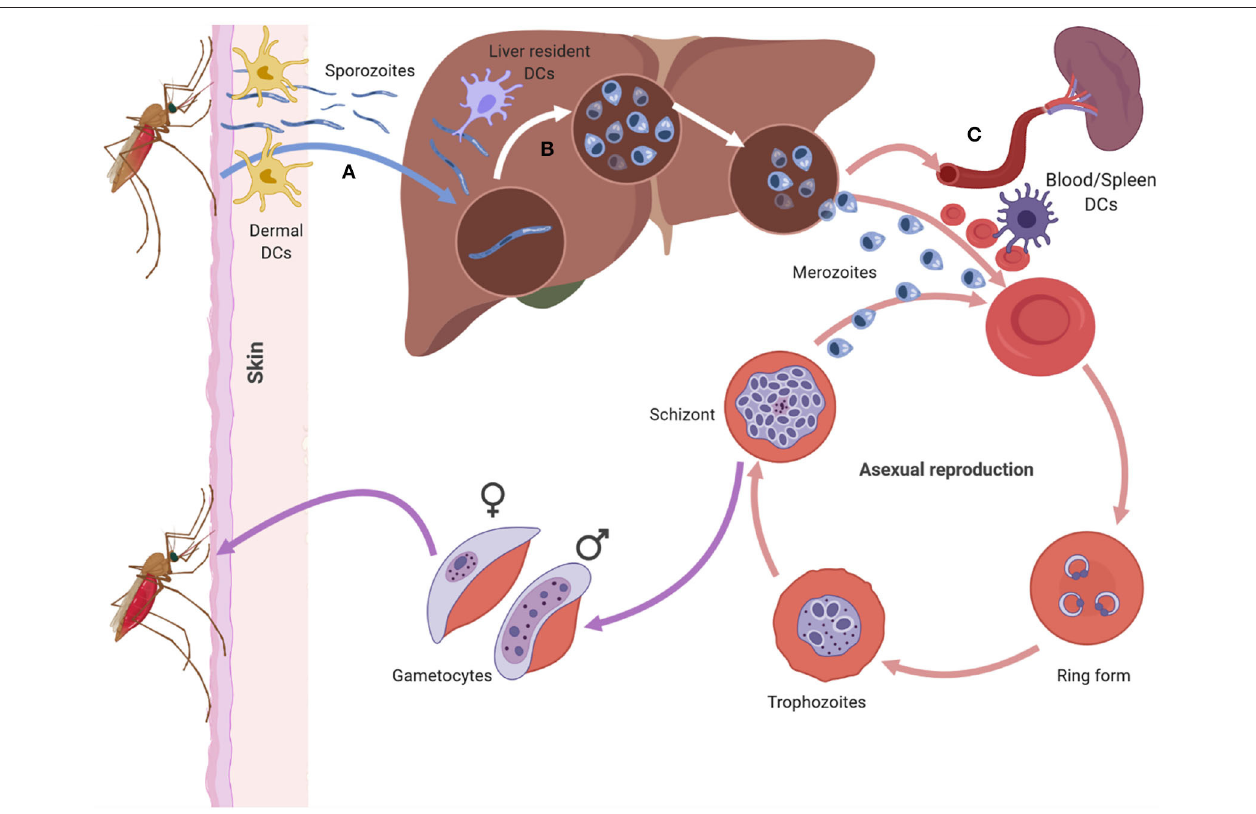
FIGURE 1 | The asexual life cycle of Plasmodium parasite begins when an infected mosquito injects highly motile sporozoites into the skin of the host. The sporozorites enters the bloodstream and migrates to the liver, where it traverses multiple hepatocytes before infecting one. Inside the hepatocyte the sporozoite undergoes pre-erythrocytic schizogony forming merozoites that accumulate and bud off the hepatocyte in structures called merosomes. Merosomes enter the bloodstream and release merozoites which invade RBC, initiating the erythrocytic stage of asexual development. At this stage the parasite develops inside the RBC in distinct forms namely the ring, trophozoite, and schizont form. The schizont, lyses releasing merozoites into the blood stream which reinvade RBCs starting a fresh round of asexual development. After rounds of erythrocytic schizogony some of the asexual parasites develop into gametocytes and are taken up by a mosquito during a blood meal. Dendritic cells can interact with sporozoites in the dermis (A) , the liver (B) and the blood and spleen (C) . The DCs at each site encounter the parasite in its different forms (Figure was created using